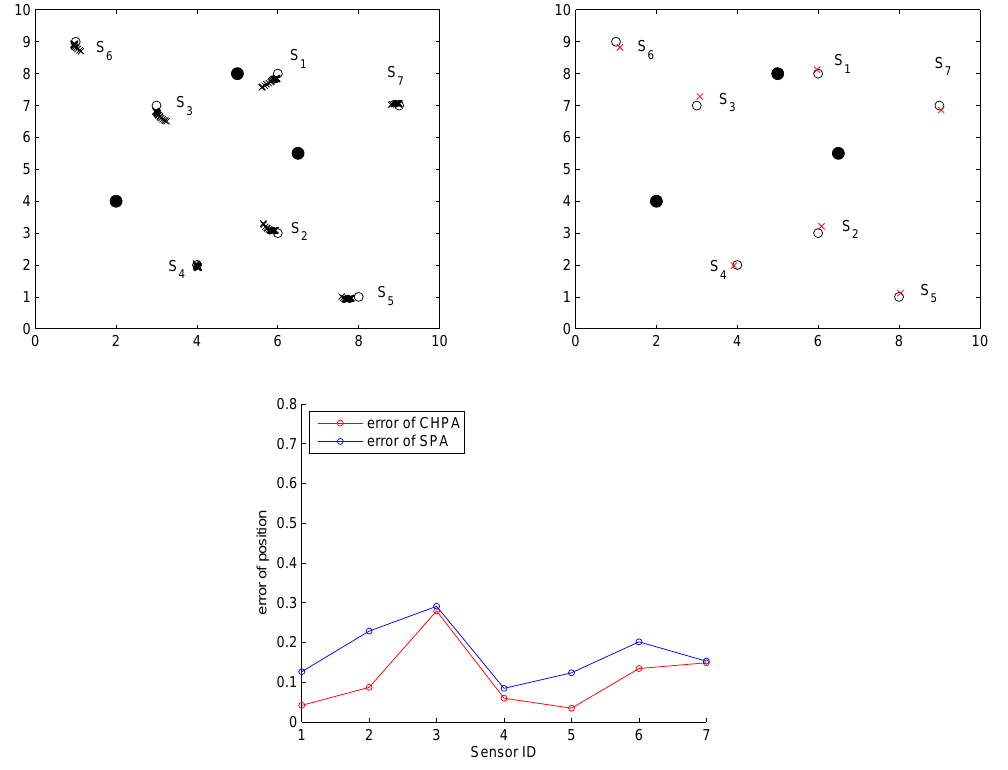
Figure 18. The average position error of each unknown sensor with the measurement noise σ 2 = 0 . 01 ; the proposed CHPA (top left); the SPA (top d